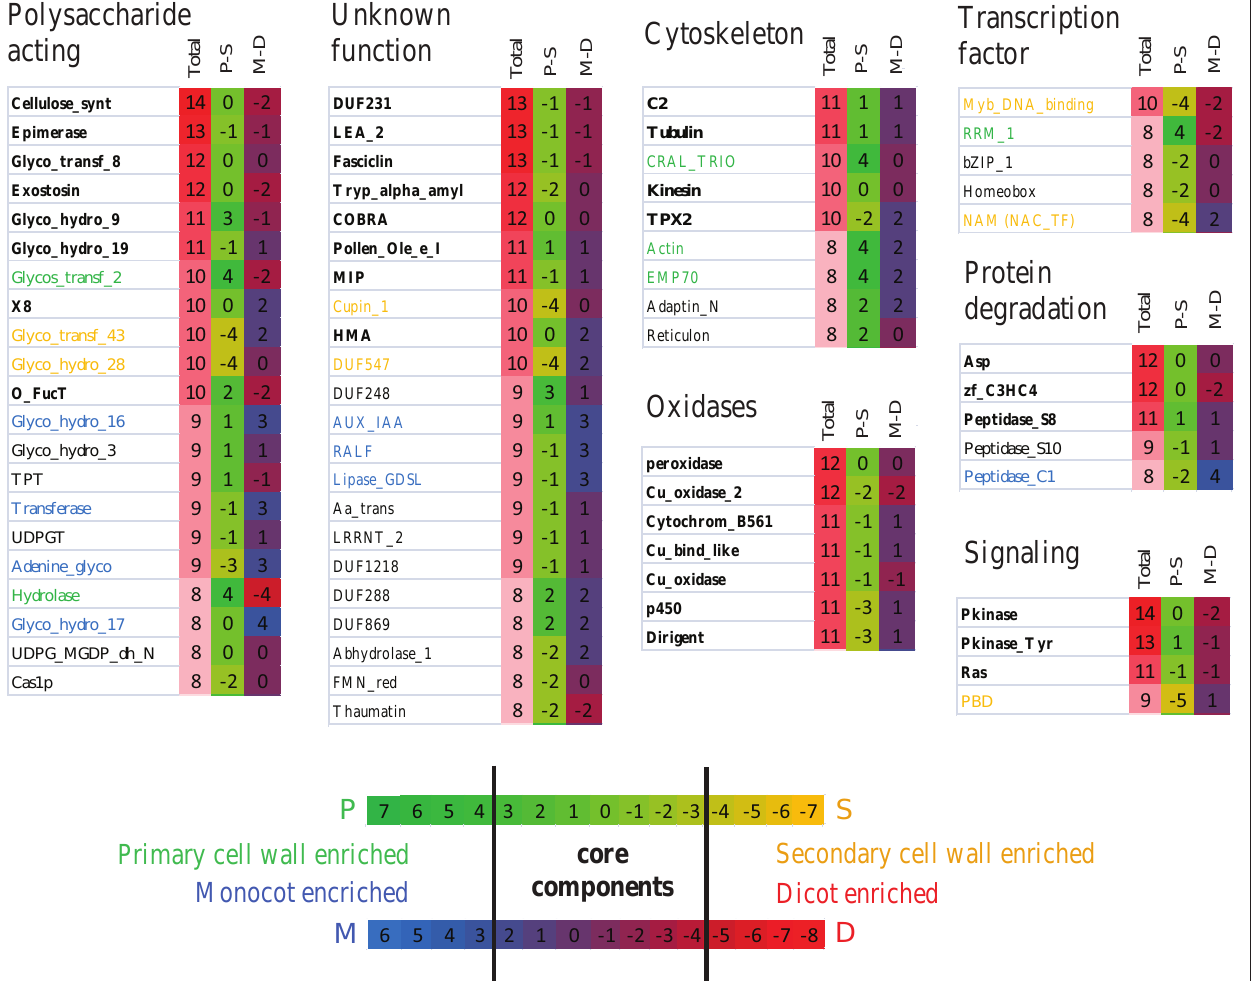
Figure 3 | Analysis of primary and secondary cellulose biosynthesis networks in the seven species using Network Comparer. Seven primary cell wall and seven secondary CESA gene vicinity co-expression networks have been analyzed for enrichment of PFAMs. Total presence of at least one gene of the respective PFAM in the fourteen co-expression networks is indicated in the first column. The heatmaps in the second and third column represent enrichment of a gene family in primary (P) or secondary cell walls (S) and monocots (M) or dicots (D) based on the difference of occurrence of genes of the respective PFAM in the 14 co-expression networks. For example, the genes from the NAM family (Transcription factor section) are present in two primary (P) and six secondary (S) co-expression networks ( Table S1 in Supplementary Material), which sums up to eight in total (first column), and